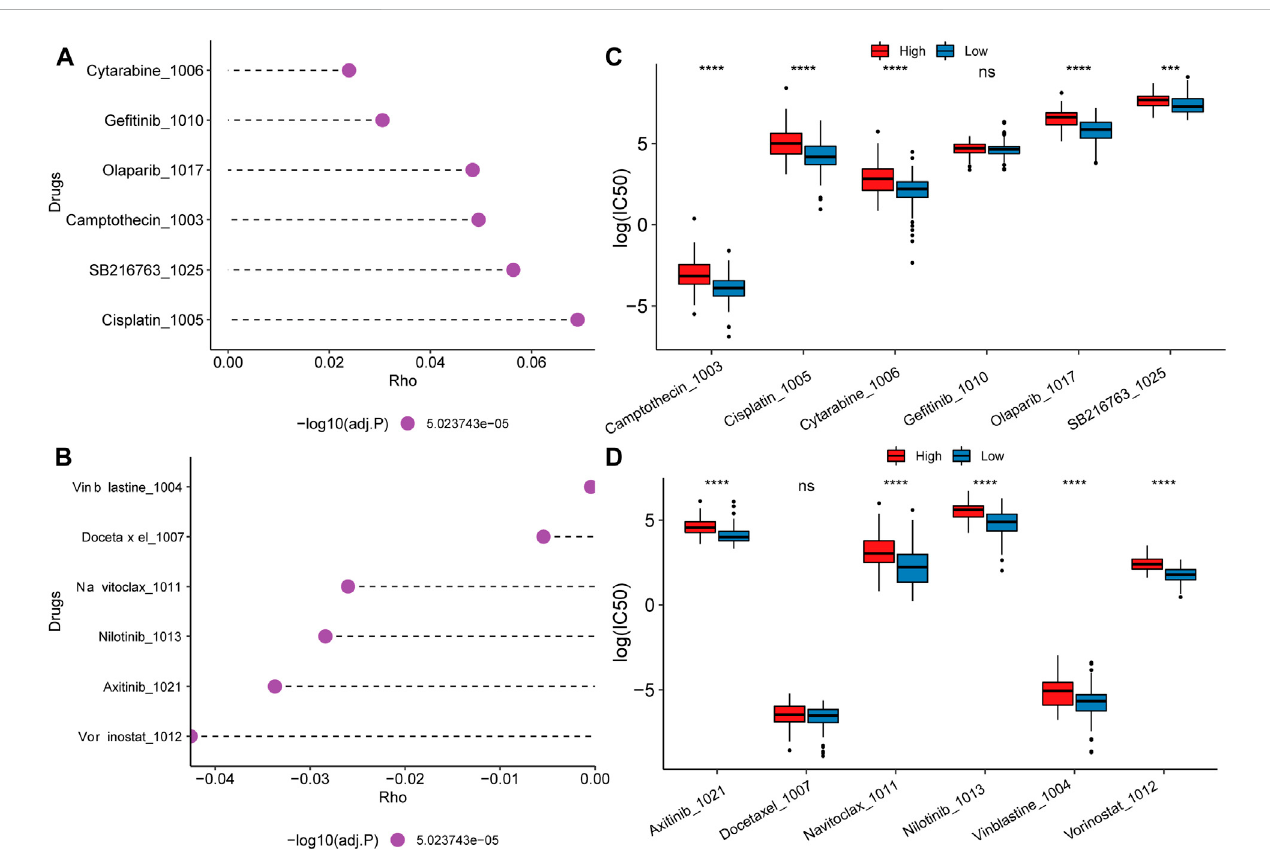
FIGURE 8 Drug resistance analysis and potential therapeutic compounds. (A) Top 6 drugs whose IC50 positively correlated with the risk score; (B) Top 6 drugs whose IC50 negatively correlated with the risk score; (C, D) IC50 distribution difference of positive and negative related drugs between high and low score